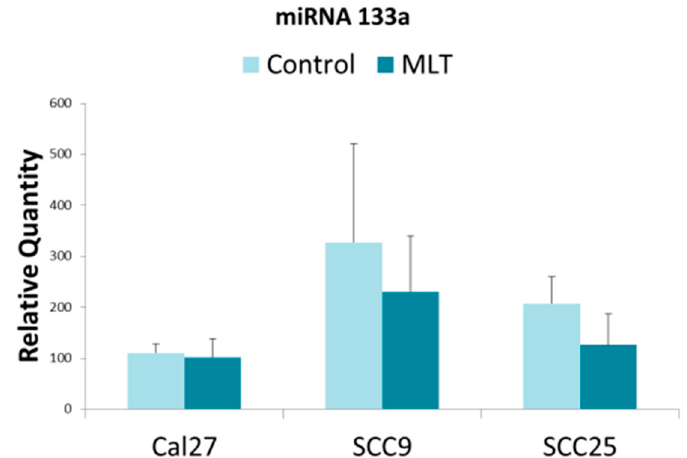
Figure 2. Relative miR-133a expression in oral cancers under melatonin (MLT) administration. Histogram of quantitative PCR from cDNAs derived from extracellular vesicles demonstrated di ff erential baseline expression of miR-133a including standard deviation (SD), which was not significantly altered in any cell line under melatonin administration (CAL27, p = 0.11; SCC9, p = 0.634; SCC25, p = 0.411).